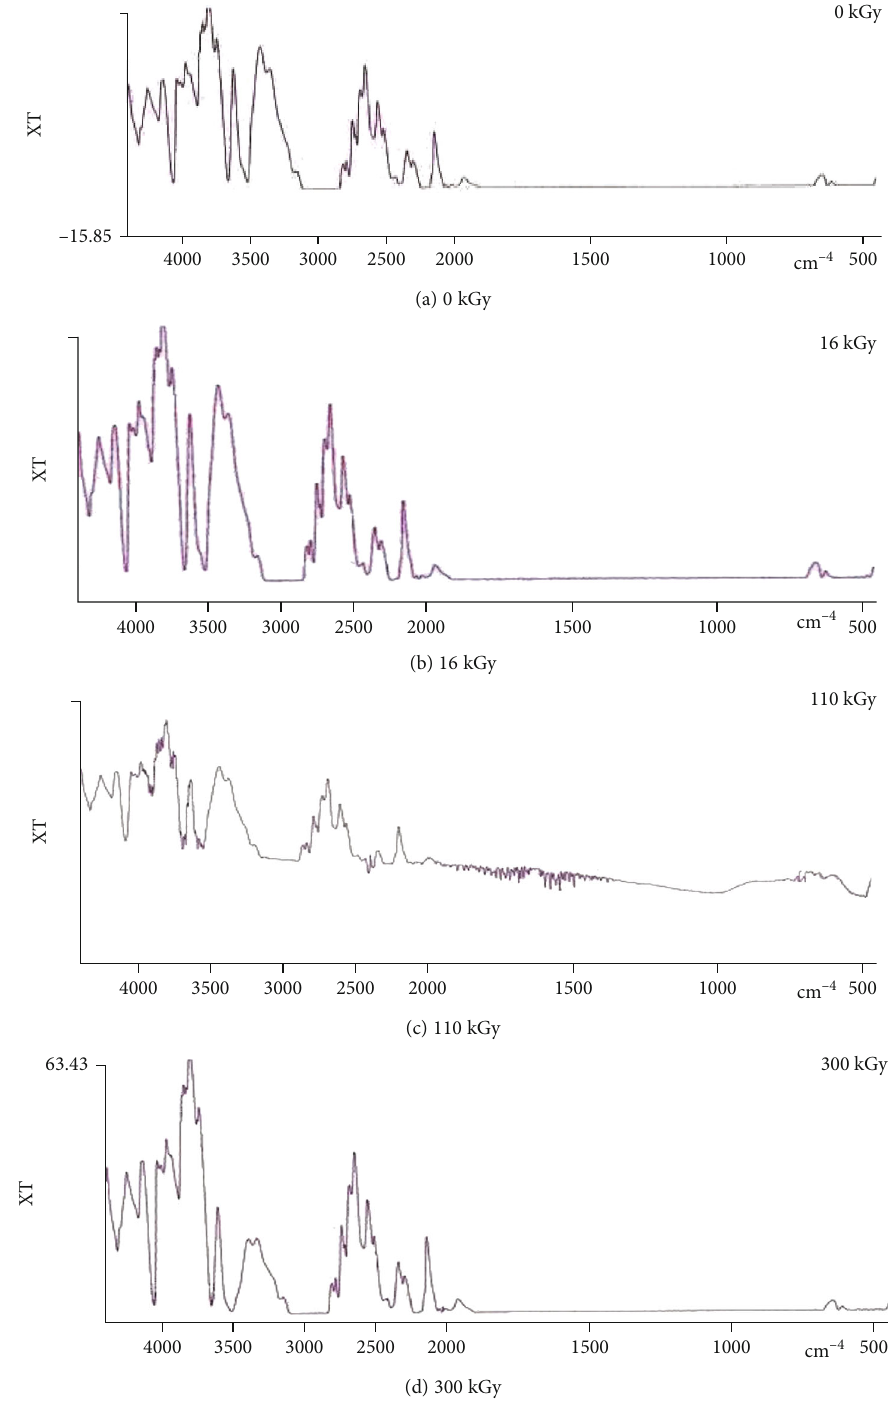
Figure 6: FTIR of (a) pristine and gamma-irradiated UHMWPE at 0kGy, 16 kGy, 110kGy, and 300 kGy radiation